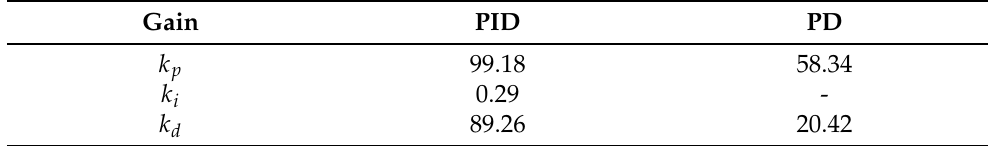
Table 4. PID and PD gain values.